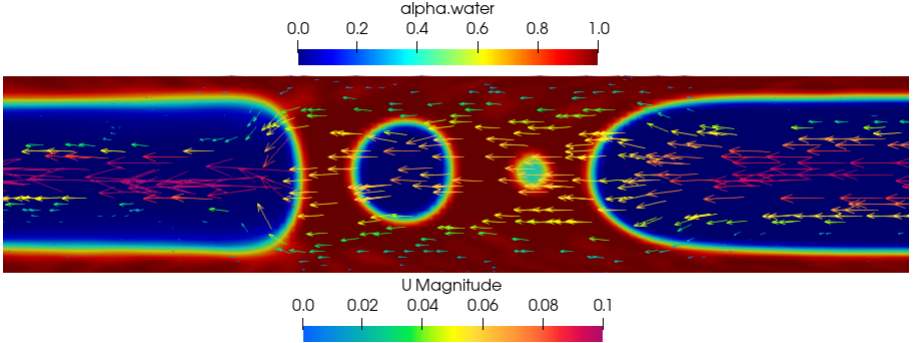
Figure 25. Distribution of velocity vector along the pipe in the Xu model, speed expressed in